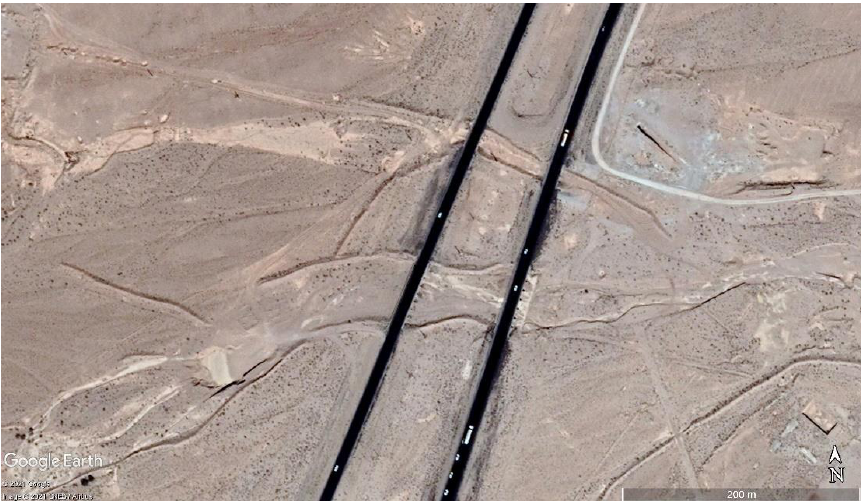
Appl. Sci. 2021 , 11 , x FOR PEER REVIEW Figure 12. The bridge No. 3 on Google Earth (Latitude: 35°57′22″ N, Longitude: 54°01′54″ E). Figure 12. The bridge No. 3 on Google Earth (Latitude: 35 ◦ 57 (cid:48) 22” N, Longitude: 54 ◦ 01 (cid:48) 54” E).